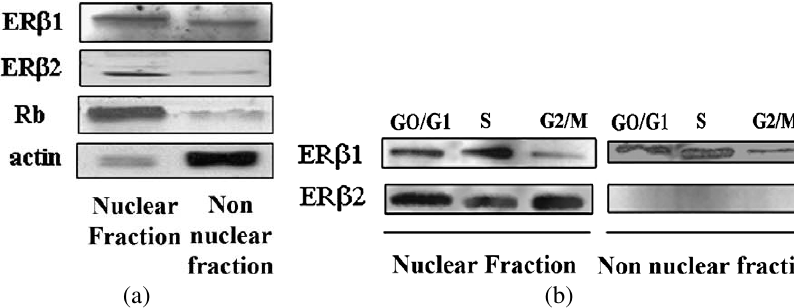
Fig. 4. Subcellular localization of ER β isoforms. (a) Western blot analysis of ER β 1, ER β 2, actin and the retinoblastoma protein in nuclear and non-nuclear fractions obtained from LNCaP cells. (b) Western blot analysis of ER β 1 and ER β 2 in nuclear and non-nuclear fractions obtained from synchronized LNCaP cells at the G0/G1 (8 h), S (17 h) and G2/M (22 h) phases, showing the localization of ER β 1 within nuclear and non-nuclear fractions and ER β 2 exclusively within the nuclear fractions at all phases.